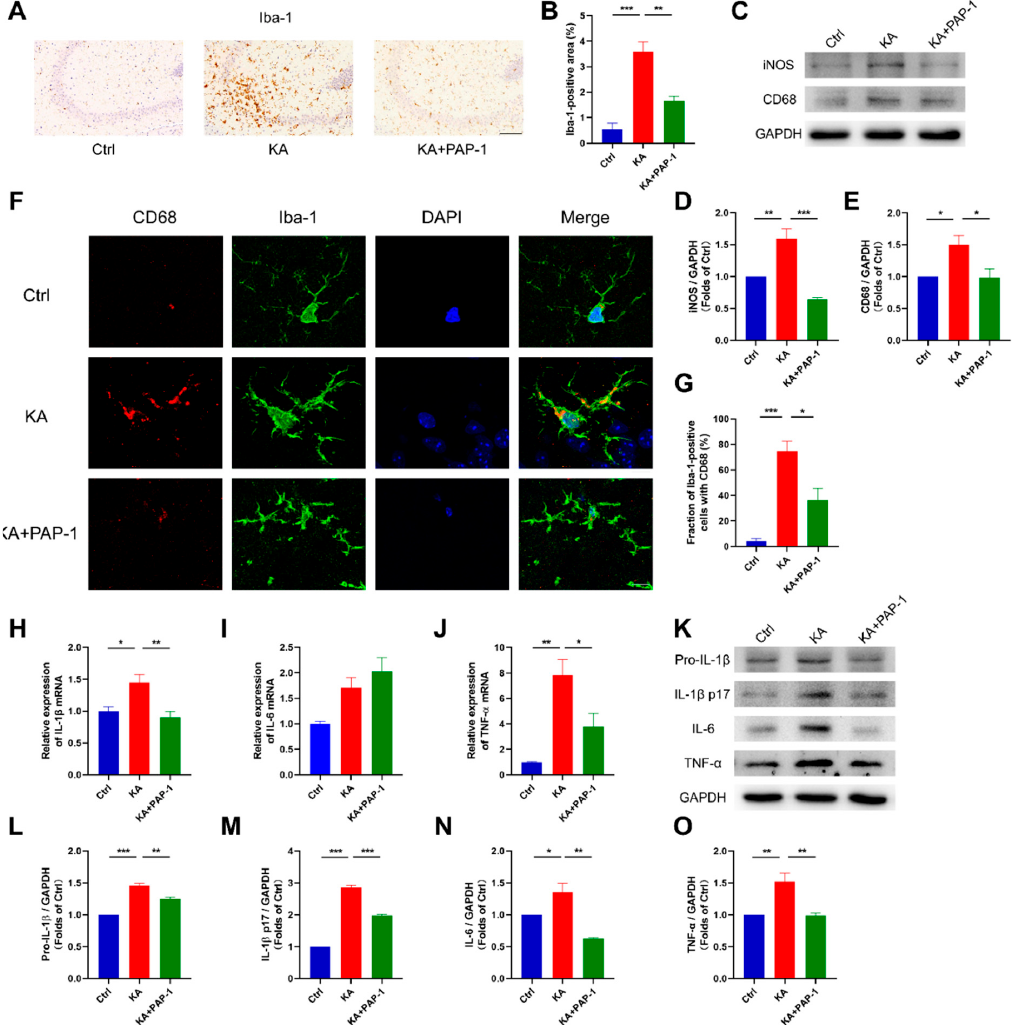
Figure 3. PAP-1 reduced microglial activation and proinflammatory cytokine production in vivo. ( A , B ) Iba-1 staining of the hippocampal CA3 region (n = 3); statistics by one-way ANOVA with